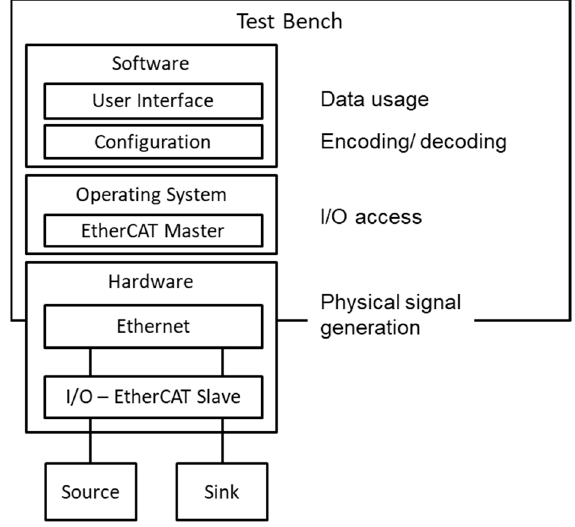
Figure 8. Test bench architecture after the implementation of EtherCAT for the